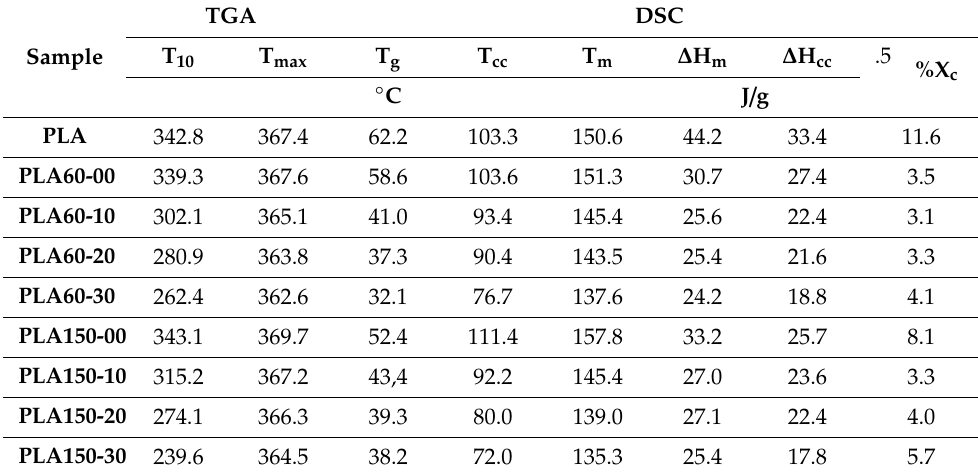
Table 1. Thermal properties of PLA and PLA /